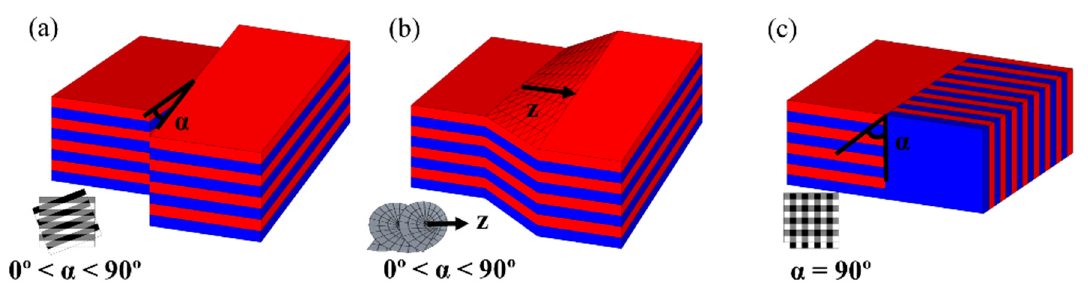
Figure A1. Different types of twist grain boundaries and their corresponding inter-material dividing surface (IMDS). ( a ) Two grains of lamellar block copolymers under a twist angle α ≪ 90°; the grey areas of the inset represent the IMDS reconstructed in a Scherk surface; ( b ) two grains of lamellar block copolymers under a twist angle α ≪ 90°, the inset represent the IMDS reconstructed in a helicoid shape; ( c ) two grains of lamellar block copolymers under a twist angle of 90°, the grey areas of the inset represent the IMDS reconstructed in a Scherk surface.